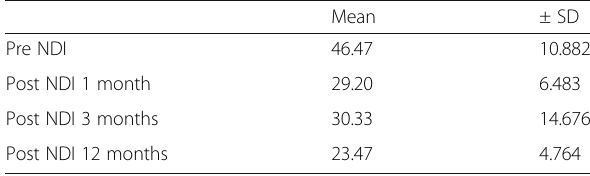
Table 5 Comparison between preoperative VAS-N and at different follow-up intervals among DCI group